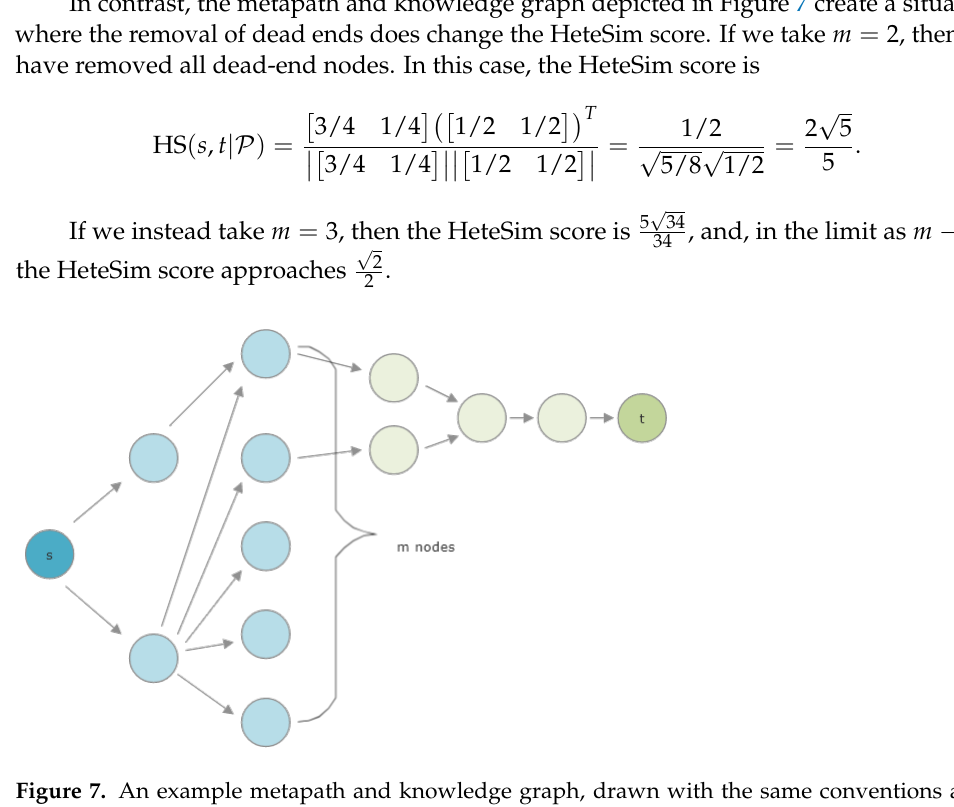
Figure 7. An example metapath and knowledge graph, drawn with the same conventions as in Figure 6. Note that, in this example, the removal of dead ends does change the HeteSim